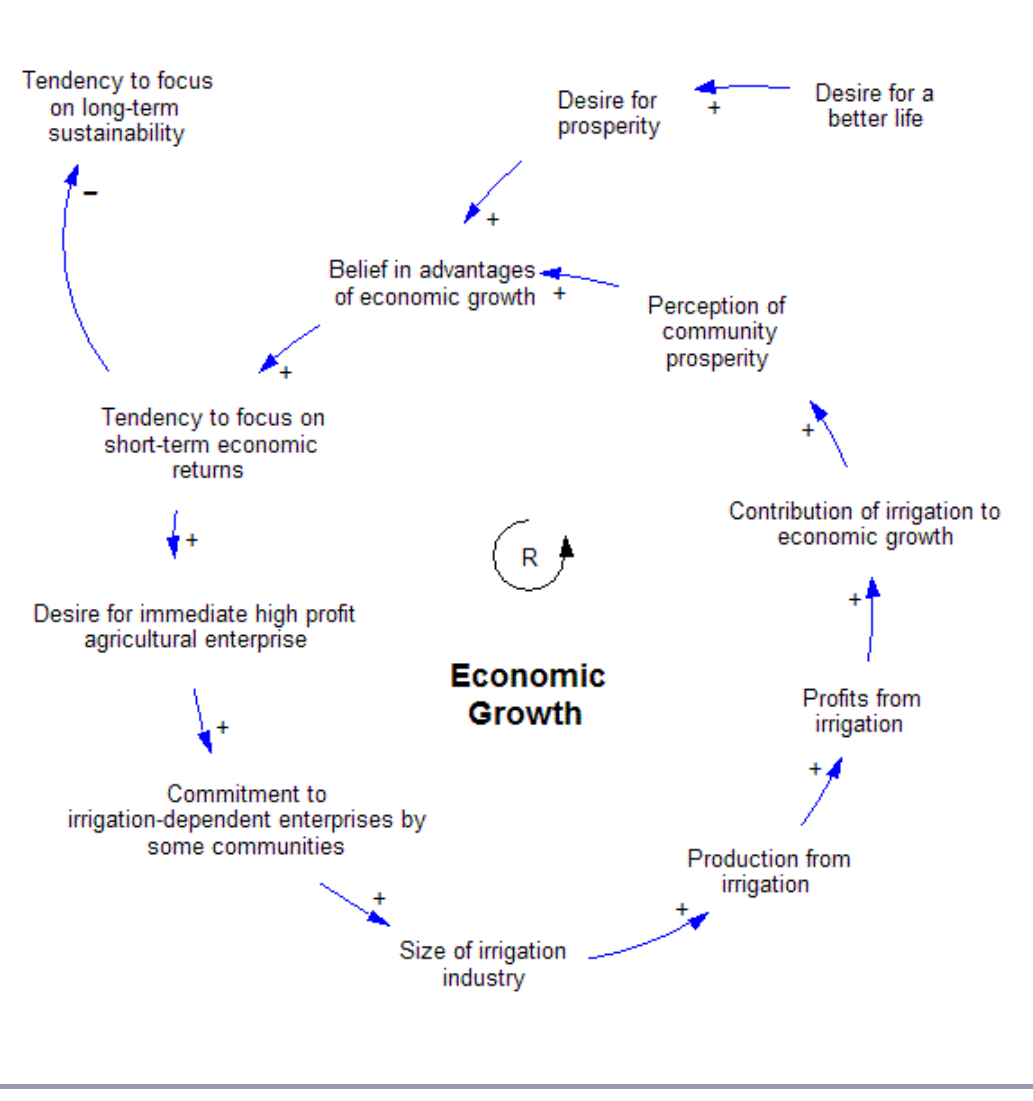
Fig. 3. Economic growth. The reinforcing causal loop (R) illustrates some of the social factors contributing to, and arising from, a belief in the advantages of economic growth. As the tendency in the community to focus on the short-term economic returns from irrigation increases, it reduces the tendency to focus on long-term